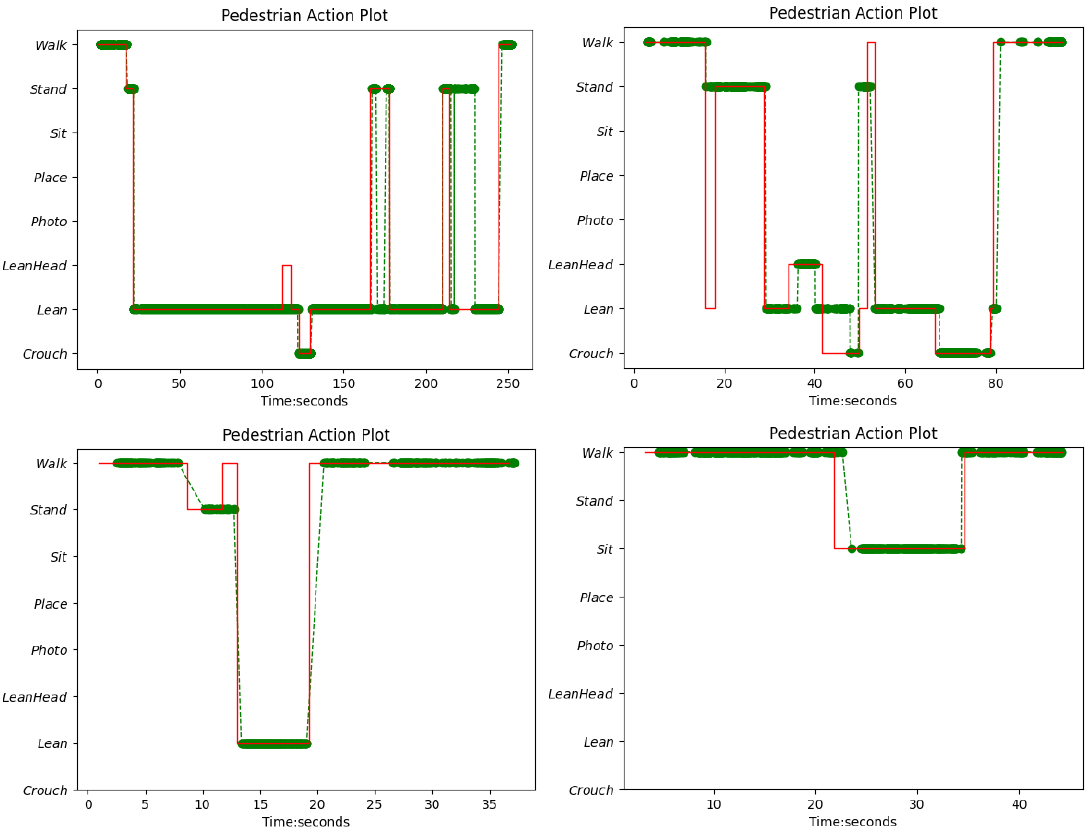
Figure 11. Sample high-risk action graphs ( top left and top right ) and normal-action graphs ( bottom left and bottom right ) with ground truth. The green dotted line is the prediction and the red line is the ground truth.